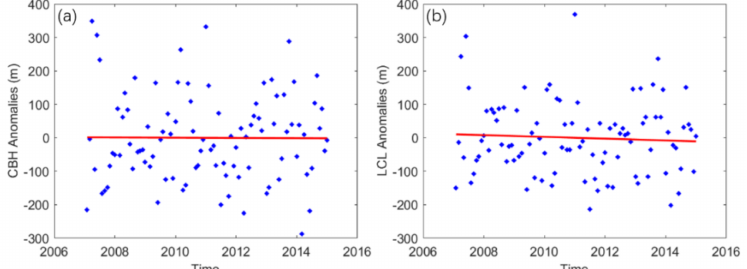
Figure 7. Monthly anomalies of ( a ) cloud base height and ( b ) lifting condensation level at LGA station.